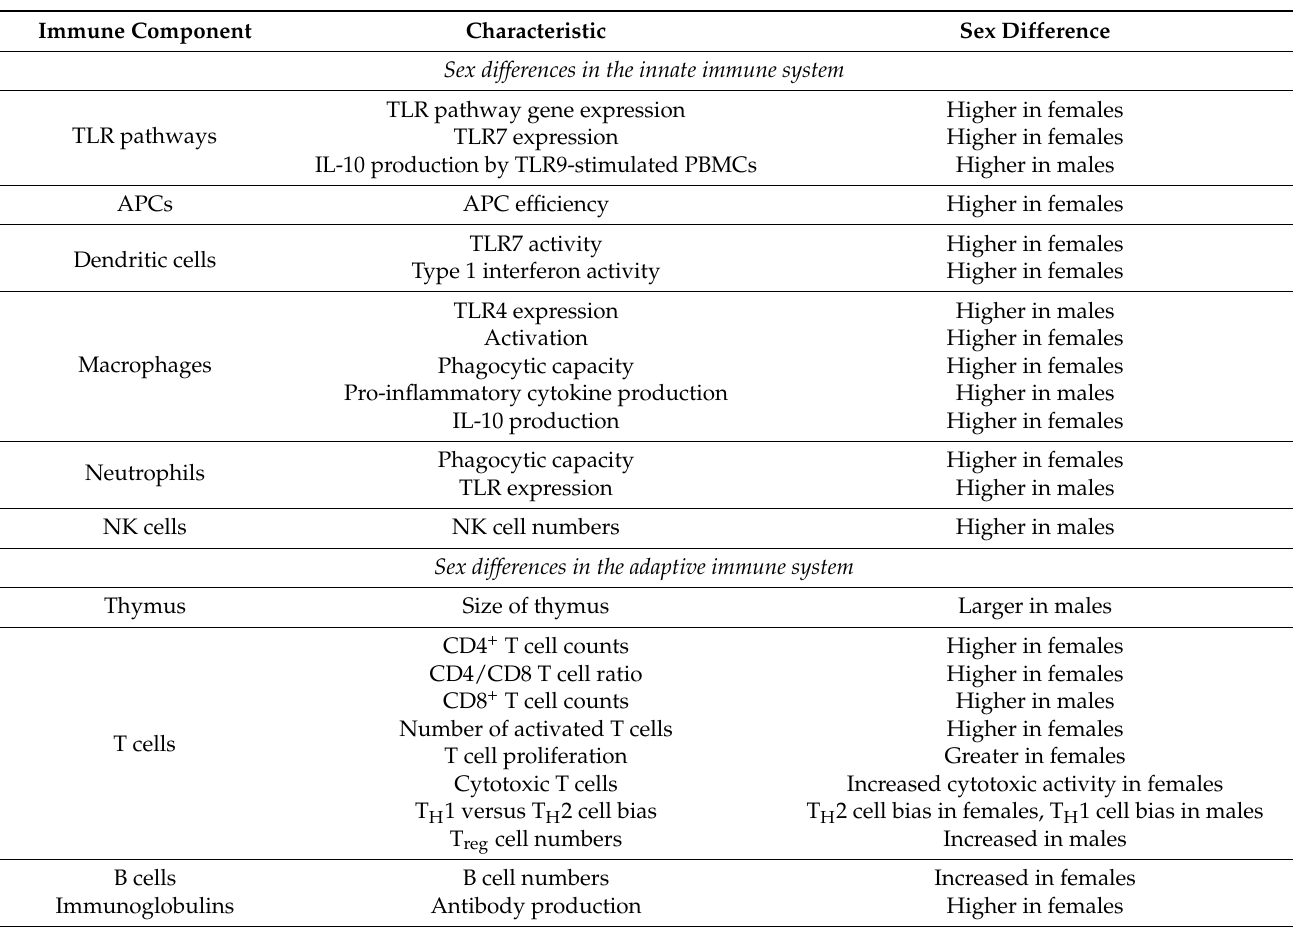
Table 1. Sex differences in innate and adaptive immune responses in adults